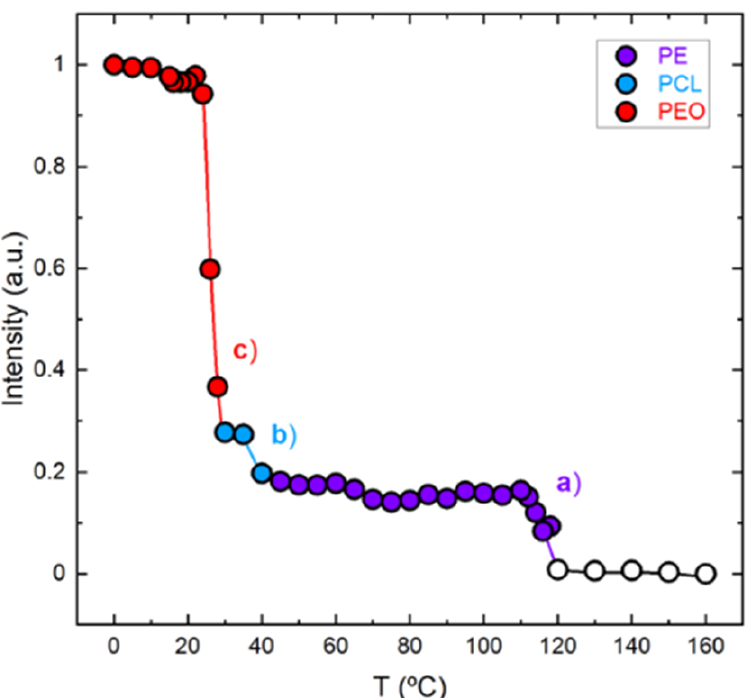
Figure 14. PLOM intensity measurement from data in Figure 13 as a function of temperature during cooling from the melt (20 °C/min), indicating crystallization of the following: (a) the PE block, (b) the PCL block, and (c) the PEO block for the triblock terpolymer PE 379.5 - b -PEO 348.8 - b -PCL 297.6 (T2). Colored data points and lines (violet for PE, blue for PCL, and red for PEO) are employed to follow the crystallization. Empty data points correspond to the molten state of the sample .